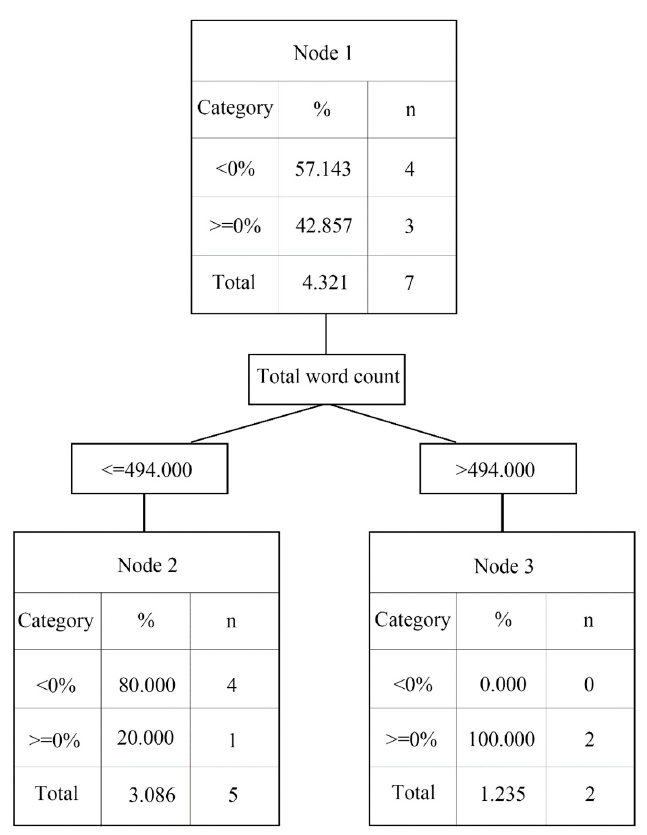
Figure 5. The classification results for N01 (USA Today).